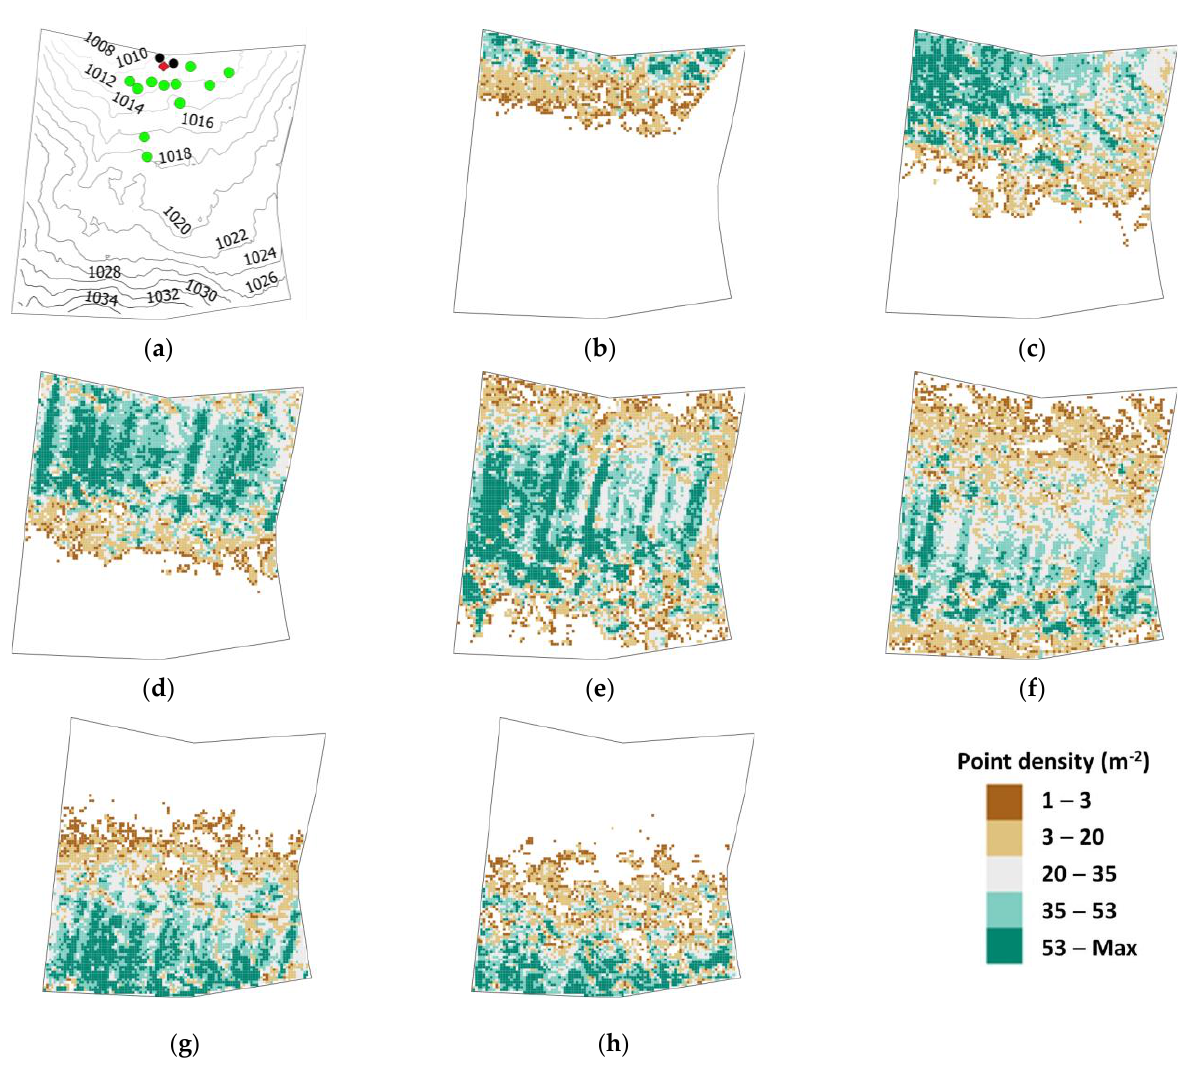
Figure 7. Topographic and LAS surveys: contour lines derived from the DTM with over-imposed survey landmarks (black dots, panel ( a ), the positioning of the ground station (red dot), the positioned trees (green dots); point density of the LAS scan lines with all returns are represented in earth tones color scale. Lines scans are reported in panels ( b – h ) ordered from north to south.